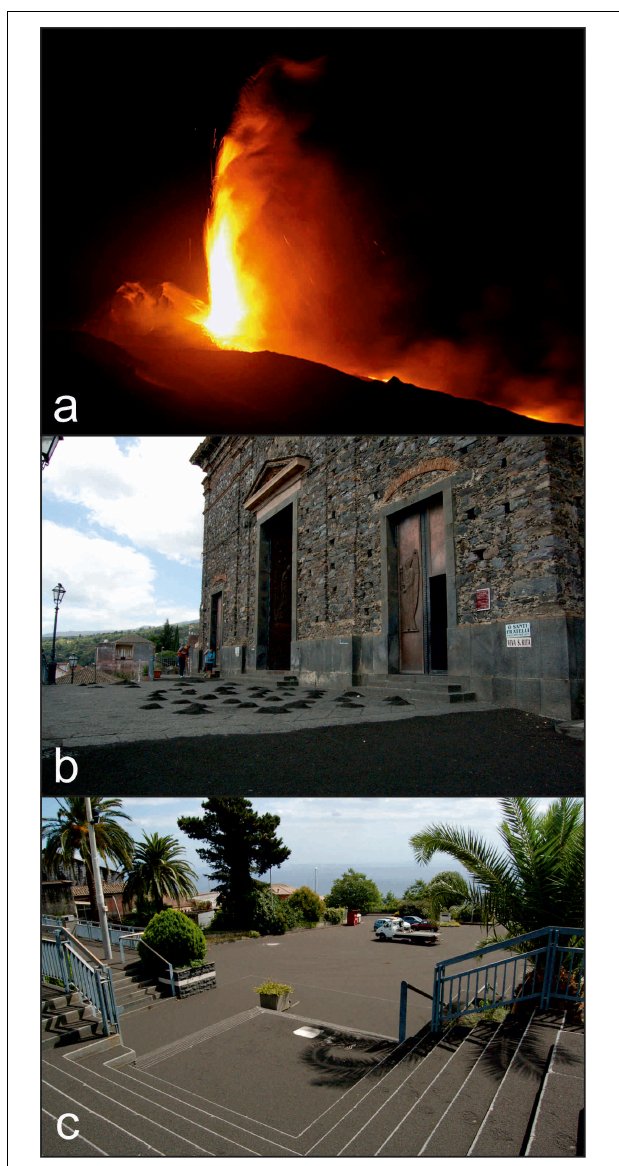
FIGURE 3 | 4–5 September 2007 lava fountain at Mount Etna: (a) magma jets from the South-East Crater (photo at https://forum.meteonetwork.it/meteo- foto/62785-eruzione-etna-04-settembre-2007-a.html); (b,c) images of the tephra deposit in the village of S. Alfio, ∼ 13 km from the vent (photo by Daniele Andronico). Reproduced with